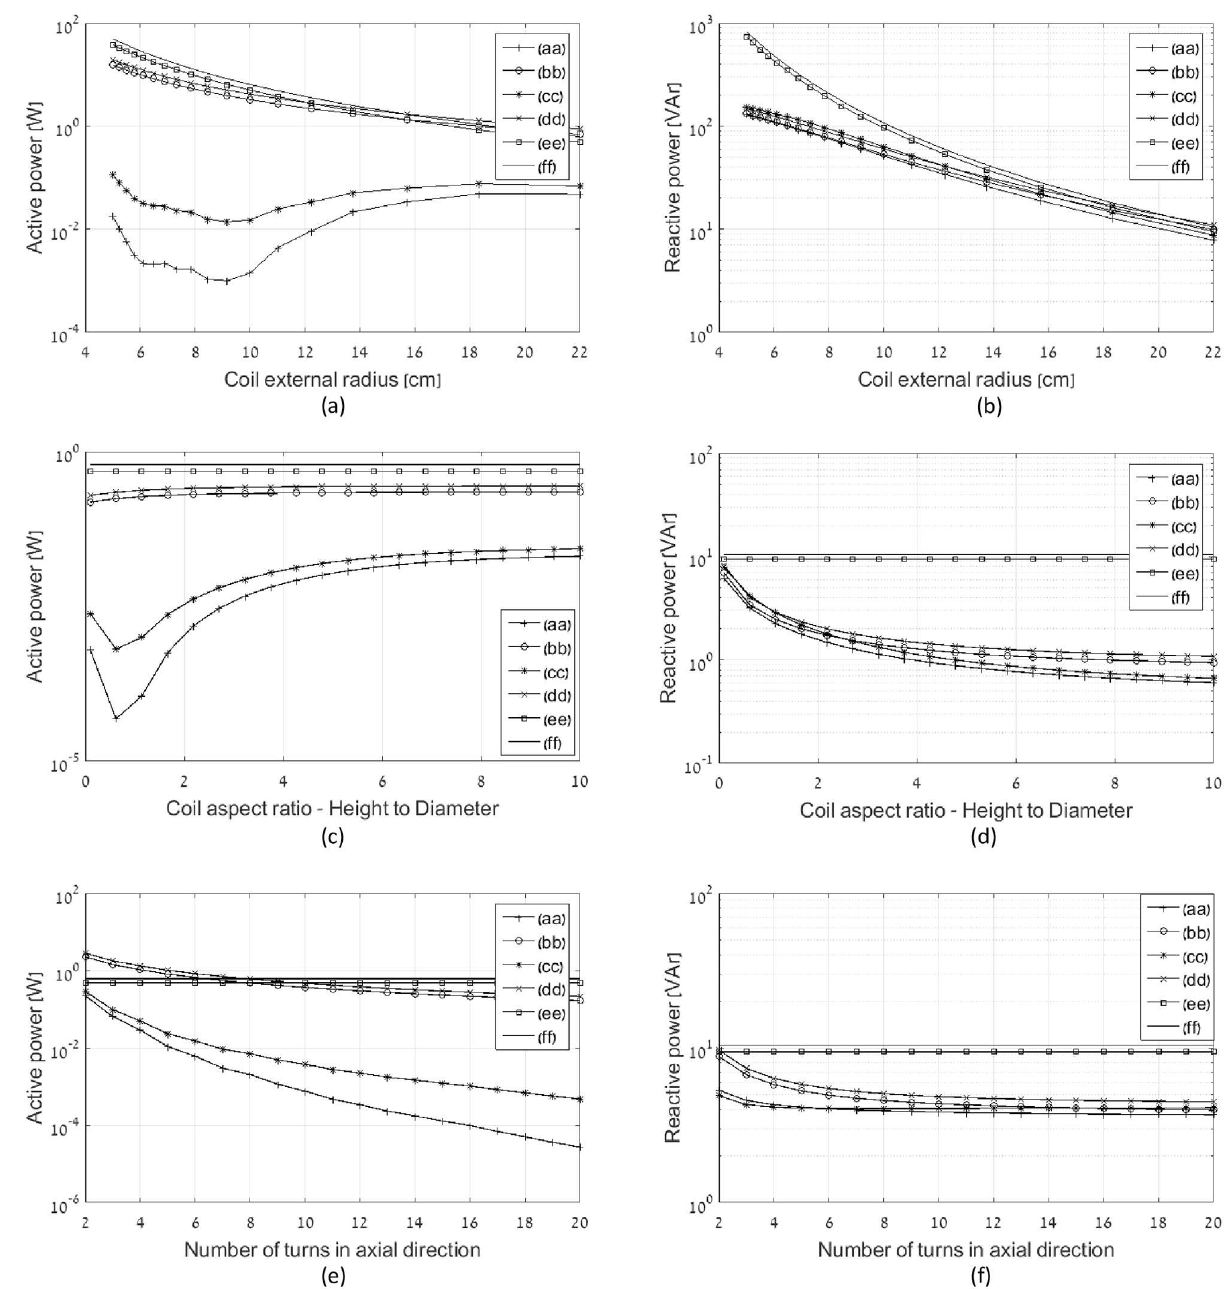
Fig 13. Active and reactive power of various coil topologies under number of constraints: (a) and (b) constant volume and weight, (c) and (d) constant external radius and weight, (e) and (f) constant coil dimensions. Legendentries: (aa) optimal multi-layer coil, (bb) optimal singlelayer solenoidcoil, (cc) constant current multi-layer coil, (dd) constant current singlelayer solenoidcoil, (ee) optimalflat coil, and (ff) constant current flat coil. coils is 10, and the coil height is 20 cm. Active and reactive power of the flat topologies having the same external radius and number of turns in radial direction is shown for reference. At all cases shown in Fig 13, the optimal multi-layer coil is significantly superior to other topologies at active power, and all 3D coils are vastly superior to flat coils at reactive power.